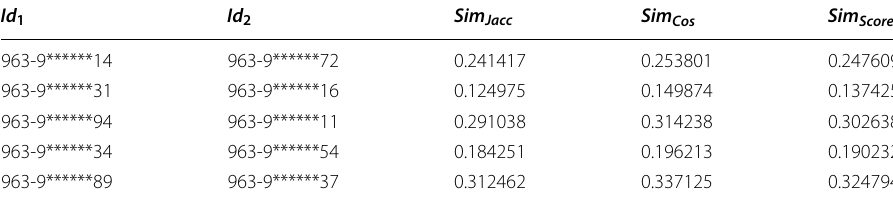
Table 7 Sample of calculated similarity SNA measures Id